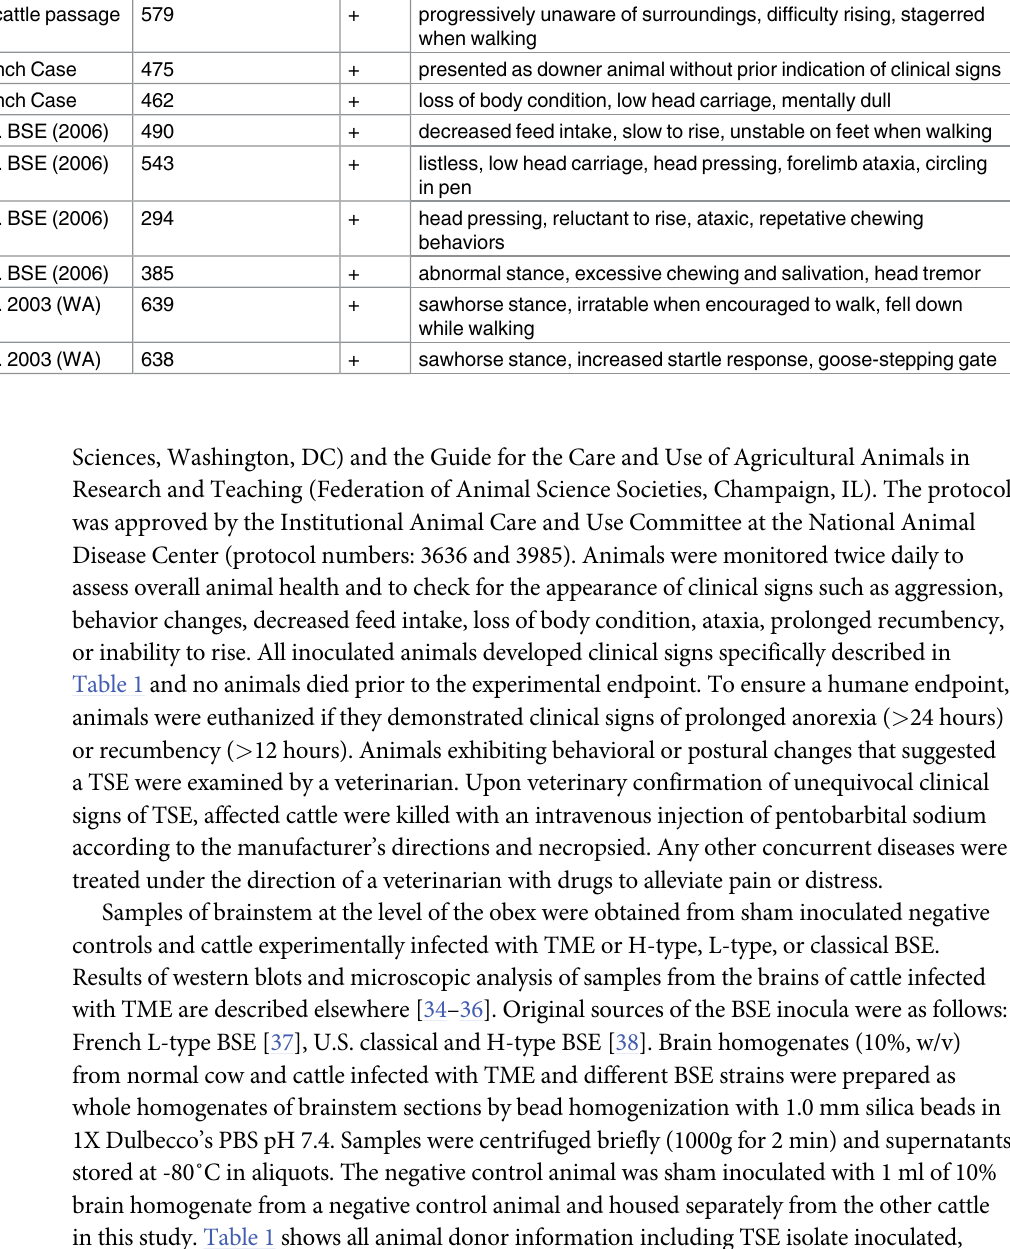
Table 1. Animal donor information. Brain tissues collectedfrom cattle that were normal or clinicallyill with BSE were used to preparehomogenates. Animal Inoculated Number TSE